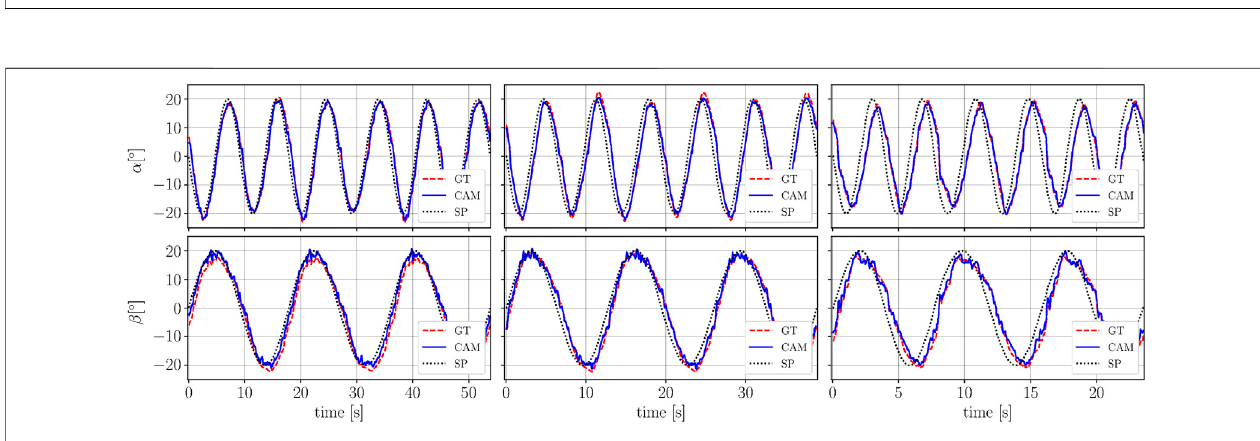
Frontiers in Robotics and AI |